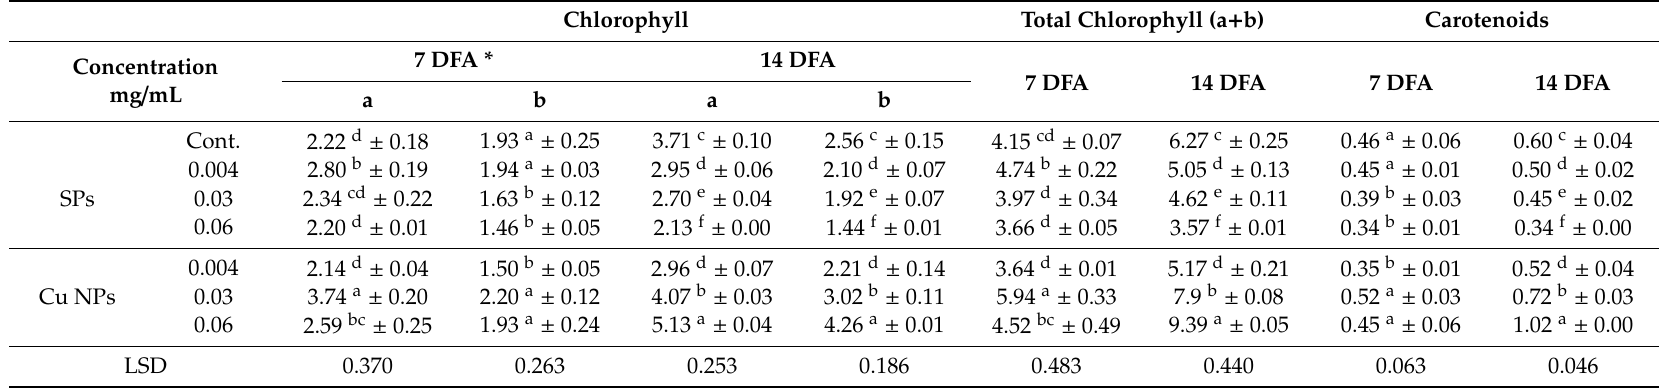
Table 5. Contents of chlorophyll and carotenoids (mg / g fresh weight) of wheat leaves exposed to a soil application of SPs and Cu NPs. Chlorophyll Total Chlorophyll (a + b)